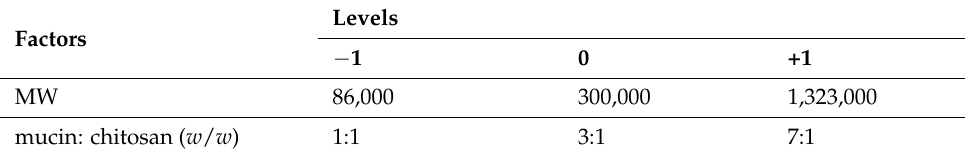
Table 1. Factors and levels of full factorial design 3 2 .